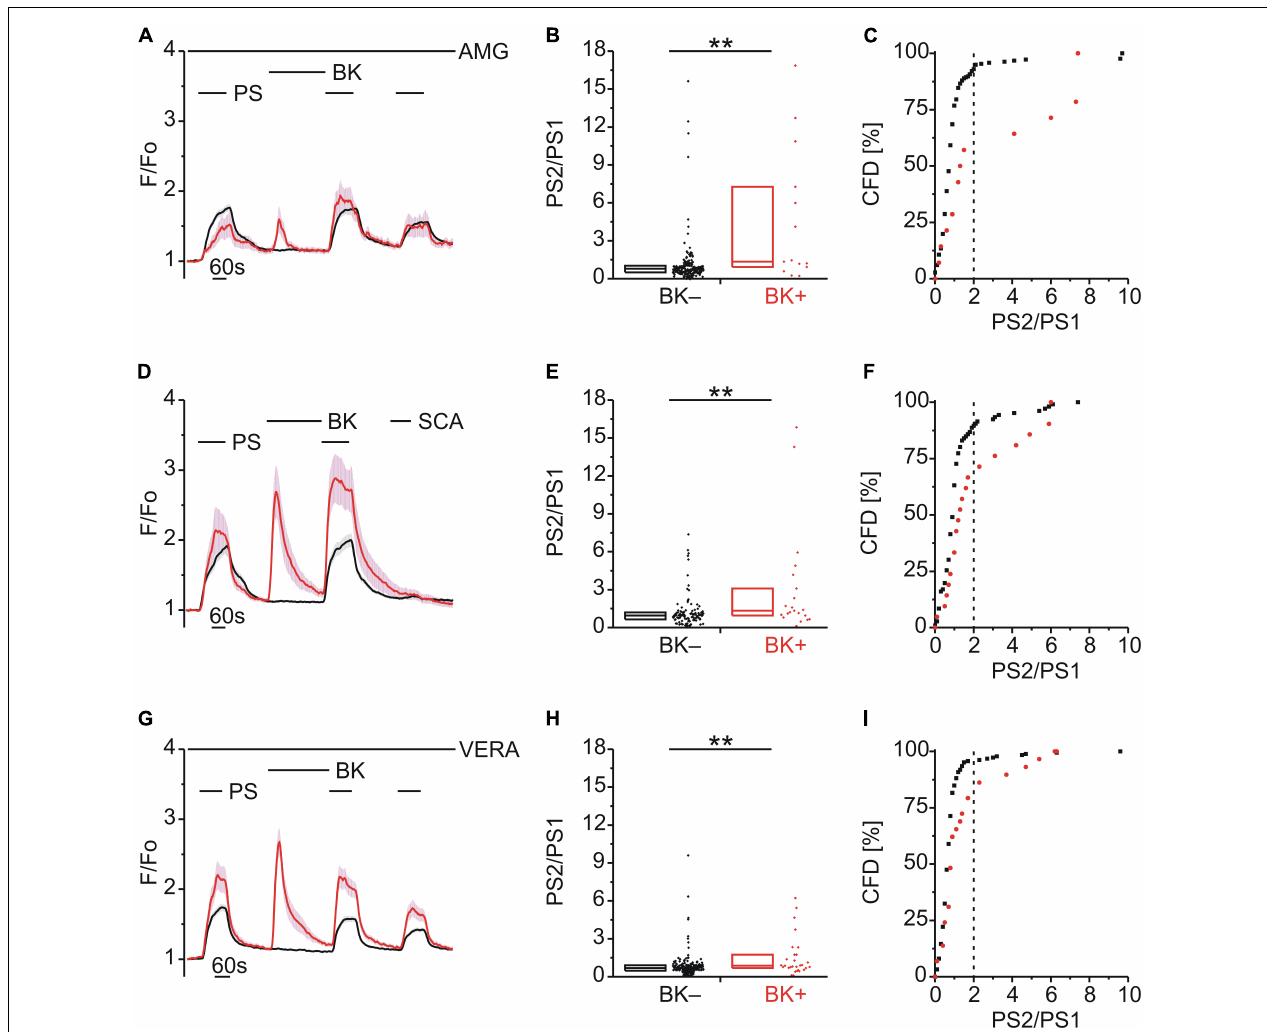
FIGURE 3 | TRPM3 sensitization following BK does not involve TRPV1, TRPA1 or CaV. (A–C) Calcium signals from DRG neurons (A) during repeat application of pregnenolone sulfate (PS; 40 µ M) with bradykinin (BK; 0.5 µ M) applied between PS1 and PS2 and in the continuous presence of the TRPV1 inhibitor AMG9810 (AMG; 4 µ M). Cells that showed an increase in calcium to BK are indicated in red (BK+; A–C ; 14 neurons) and those that did not in black (BK–; A–C ; 216 neurons). PS2/PS1 ratios are shown as a simple distribution ( B , boxes indicate quartiles and centerline median) and cumulative frequency distribution (CFD; C ). Each dot-like symbol in (B,C) represents the ratio value calculated for a single, individual cell. Values derive from seven measurements with cells from two mice. (D–F) Calcium signals from DRG neurons (D) during application of PS twice with BK applied between PS1 and PS2 and the TRPA1 agonist SCA (1 µ M) applied last of all to identify and exclude TRPA1+ cells. BK+ cells are indicated in red ( D–F ; 21 neurons) and BK– cells in black ( D–F ; 106 neurons). PS2/PS1 ratios are shown as a simple distribution (E) and CFD (F) . Values derive from four measurements with cells from one mouse. (G–I) Calcium signals from DRG neurons (G) during repeat application of PS with BK applied between PS1 and PS2 and in the continuous presence of the CaV inhibitor verapamil (VERA; 20 µ M). BK+ cells are indicated in red ( G–I ; 29 neurons) and BK– cells in black ( G–I ; 185 neurons). PS2/PS1 ratios are shown as a simple distribution (H) and CFD (I) . Values derive from six measurements with cells from one mouse. BK+ and BK– groups (B,E,H) were compared with Mann-Whitney U -tests. ** P <